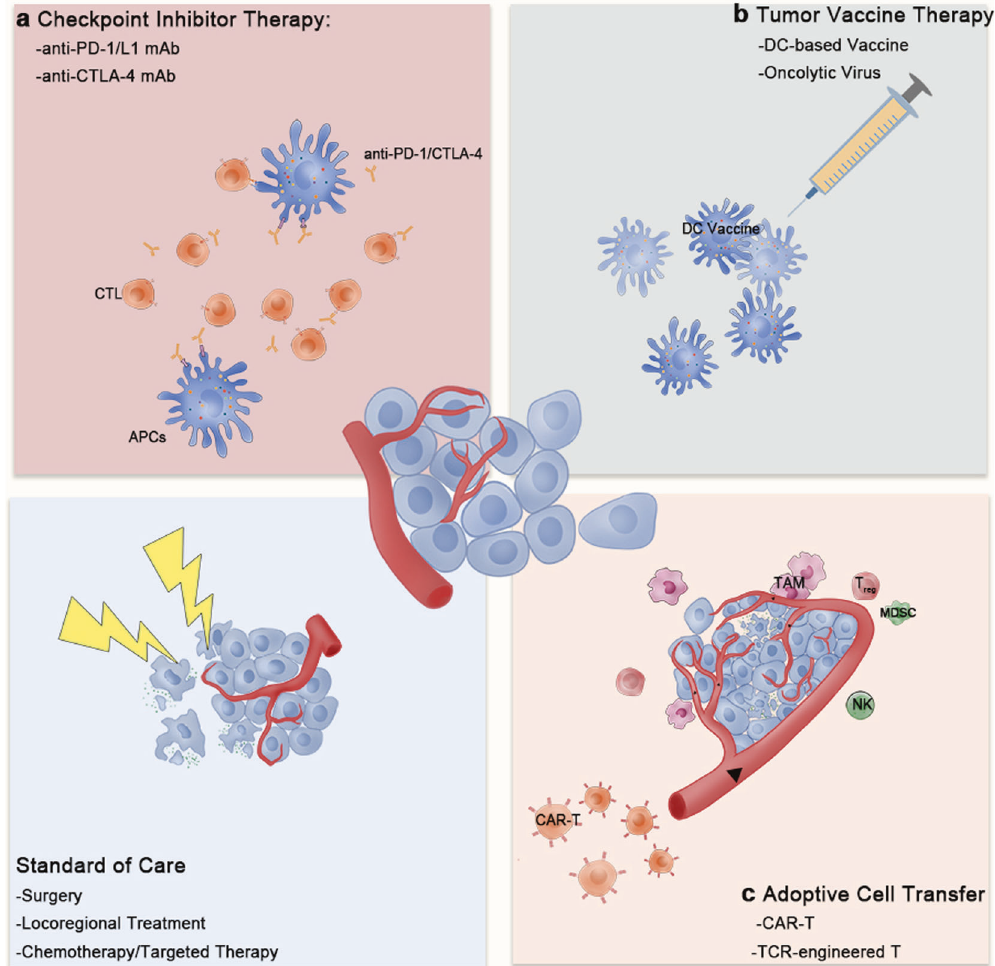
Fig. 1 Classi fi cation of current tumor immunotherapies. The current tumor immunotherapies can be roughly divided into three types: a checkpoint inhibitors, including anti-PD-1/L1 and anti-CTLA-4 monoclonal antibodies; ( b ) tumor vaccines, including various dendritic cell- based vaccines and oncolytic virus-based vaccines; and ( c ) adoptive cell transfer, including CAR-T or TCR-engineered T cells. The antigens released from necrotic tumor cells during surgery, locoregional therapy, chemotherapy or targeted therapy enhance the immune recognition of tumor